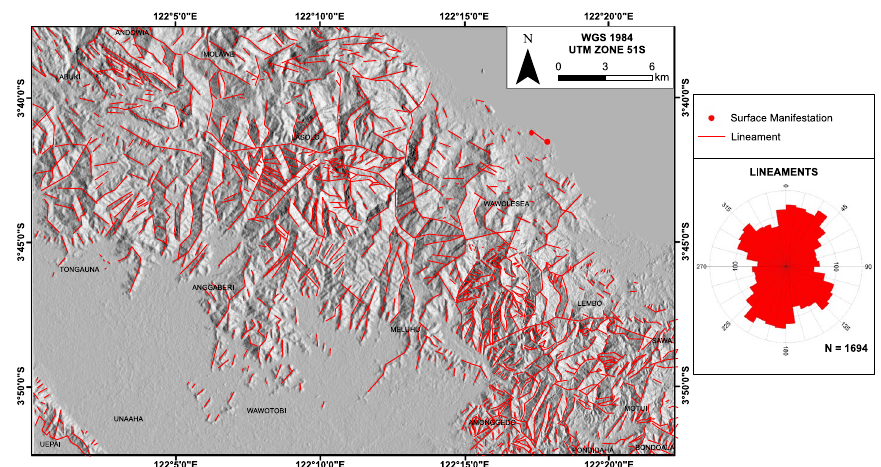
Fig. 7 Map showing the lineaments traced and interpreted in the study area